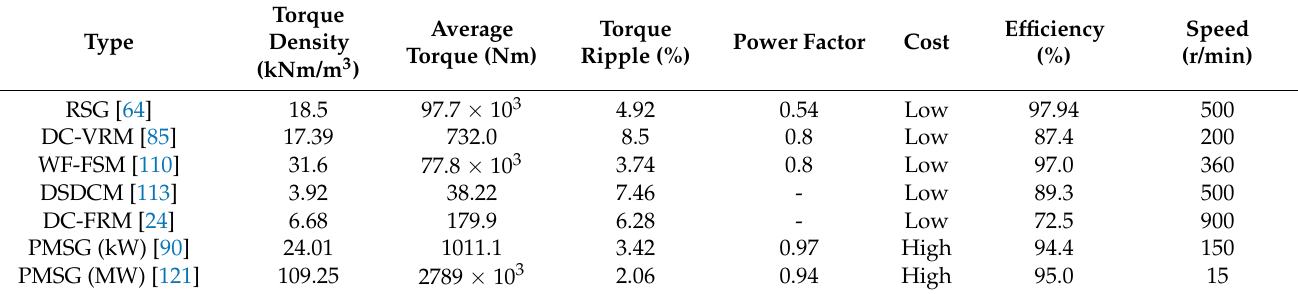
Table 2. Comparison of non-conventional non-PM wind